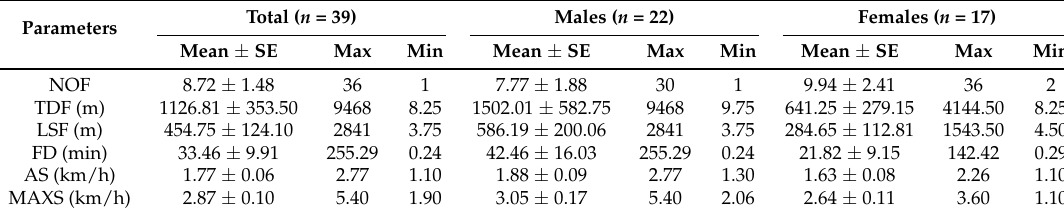
Table 6. Summary of flight parameters for S. laurasii adults.